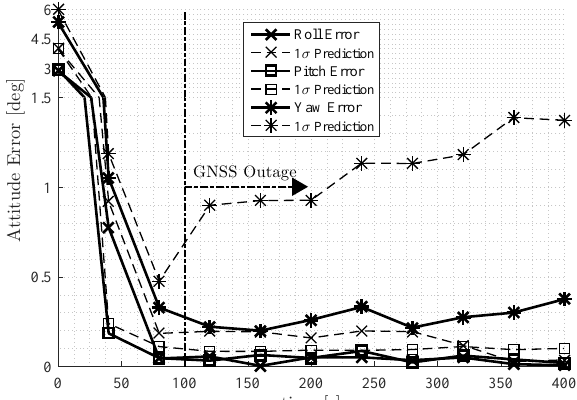
Figure 6: RMS of position and attitude errors from 100 Monte Carlo